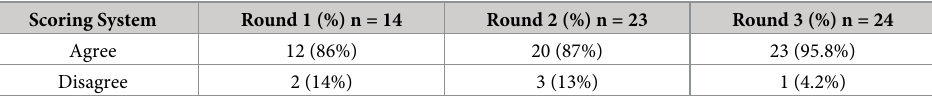
Table 5. Modified scoring system, PAL, and clerking priority in PAST tool from Delphi round 2 and